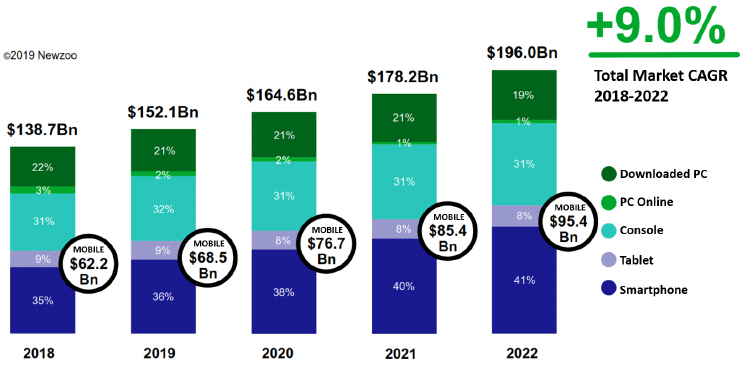
Figure 1. The annual growth rate of the total video game market. Figure by Wijman